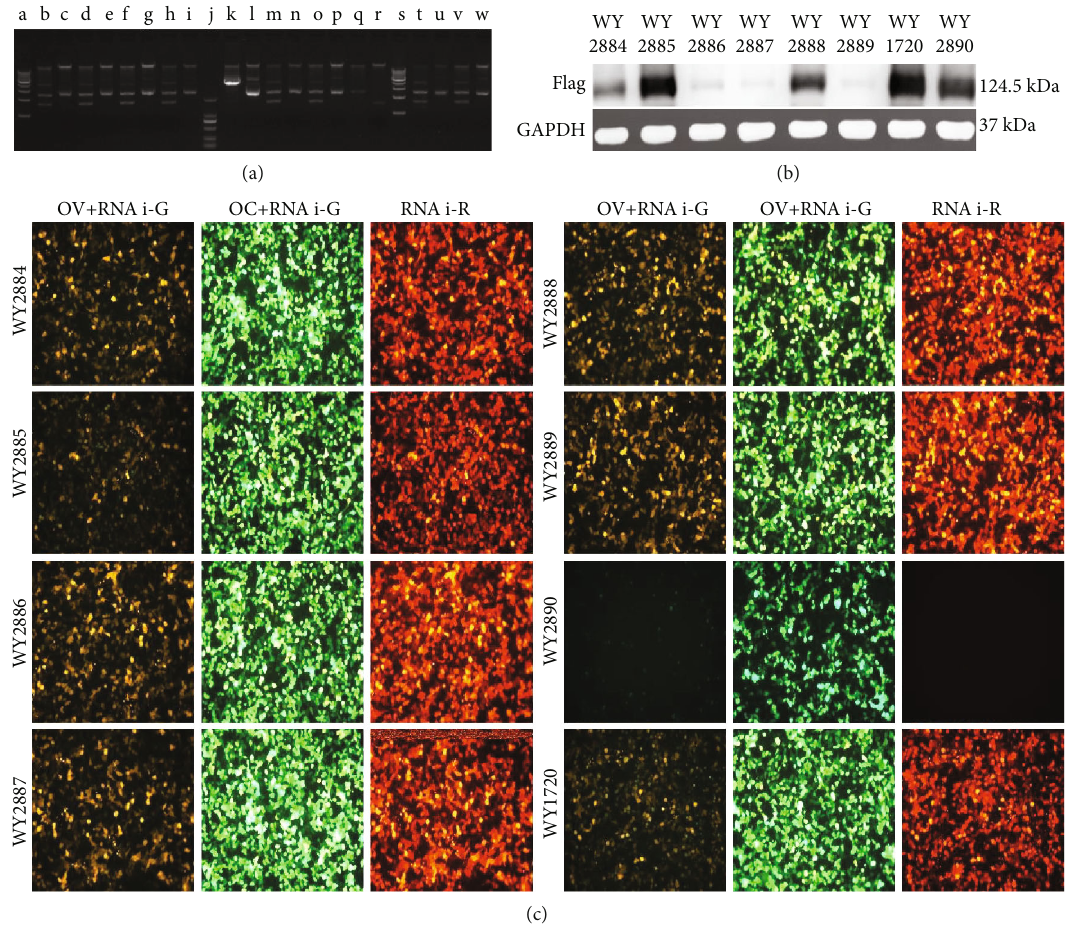
Figure 5: Sema3A in vitro target screening. (a) wy2884-2889 plasmid enzymatic digestion validation, using the enzymatic digestion site: Smal, (a and s: 1Kb DNA ladder, the bands from bottom to top are 1Kb, 2Kb, 3Kb, 4Kb, 5Kb, 6Kb, 7Kb, 8Kb, 9Kb, and 10Kb; J: DL 2000 DNA marker, the bands from bottom to top are 100bp, 250bp, 500bp, 750 bp, 1Kb, and 2Kb; b, d, f, h, k, m, o, q, t, and v were, respectively, the bands after wy2884-2889 plasmid digestion,and a, c, e, g, i, l, n, p, r, u, and w were the control bands of wy2884-2889 plasmid without enzyme digestion, and the size of each band was in line with the expectation). (b) The interference group sample wy2884-2889, the interference control samples WY1720, and the overexpressed samples WY2890 Western blotting bands. The Flag signal was obvious, and the size was 124.5kDa. As a whole, the wy2887 group had the least protein and the best interference e ff ect. The WY2886 and WY2889 groups also had less protein. (c) Representative diagram of the interference group wy2884-2889, the interference control sample WY1720 ,and the overexpressed sample WY2890 were cotransfected into 293 T cells in vitro of fl uorescence attenuation detection. The results showed that the negative control wy1720 of the interfering target had no knockdown ability. The target sequences of WY2886, WY2887, and WY2889 in the experimental group wy2884-2889 had a strong knockout ability.(OV: wy2890: pAAV-CMV_bGI-Sema3A-